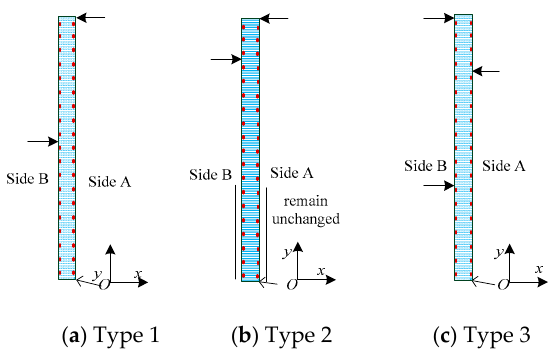
Figure 11. Schematic diagram of the different bending shapes of the FBG flexible sensor under different loading modes. ( a ) shows middle landslides and deep landslides; ( b ) shows mainly middle landslides and a deep horizontal displacement remained essentially unchanged; ( c ) shows shallow landslides and deep landslides.